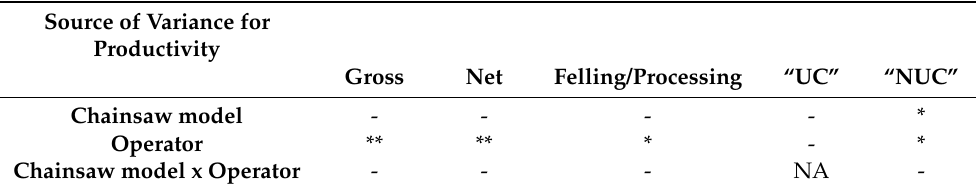
Table 4. Analysis of variance ( p -values) of the effects of chainsaw model (BAT-battery MSA 300; MIX-petrol MS 261 C-M), operator (1 or 2) and their interactions on the productivities (ANOVA multiple comparison test for gross, net, felling and processing productivity and not using chainsaw “NUC”; Kruskal–Wallis rank sum test for using chainsaw “UC” productivity). Source of Variance for Productivity Gross Net Felling/Processing “UC” “NUC” Chainsaw